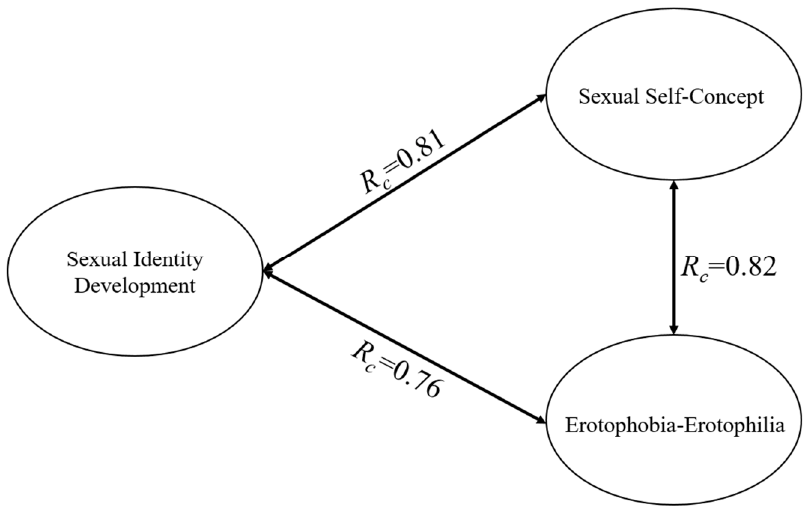
Figure 1. Pictorial synopsis of canonical correlation analyses conducted to test the hypothesized paths.